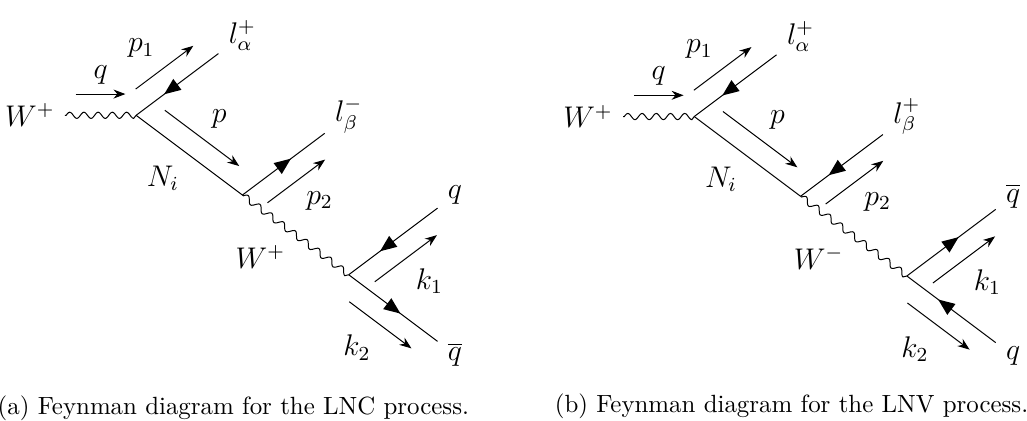
(b) Feynman diagram for the LNV process. Figure 1. Feynman diagrams describing the LNC and LNV